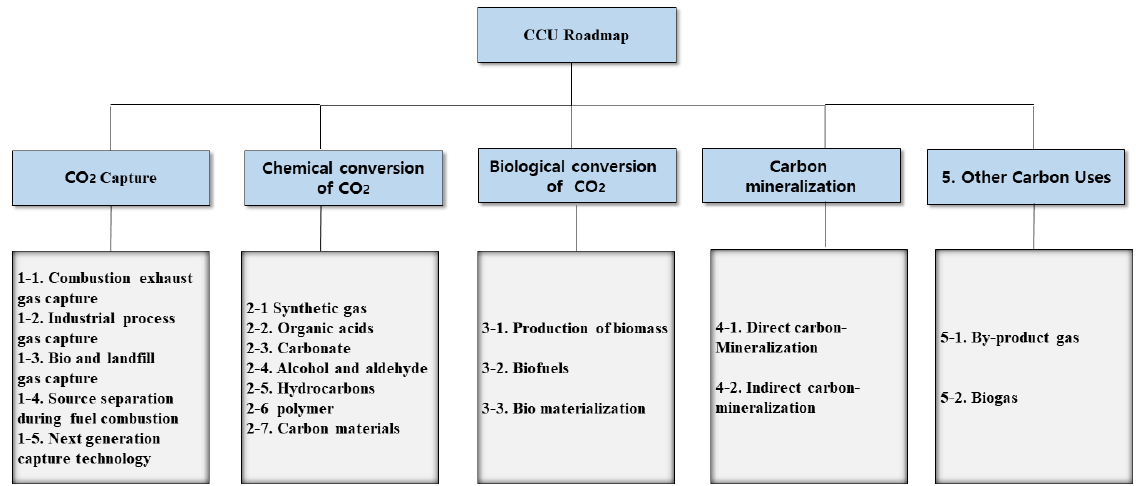
Figure 4. Carbon Capture Utilization (CCU) Technology Innovation Roadmap (data from MSIT,